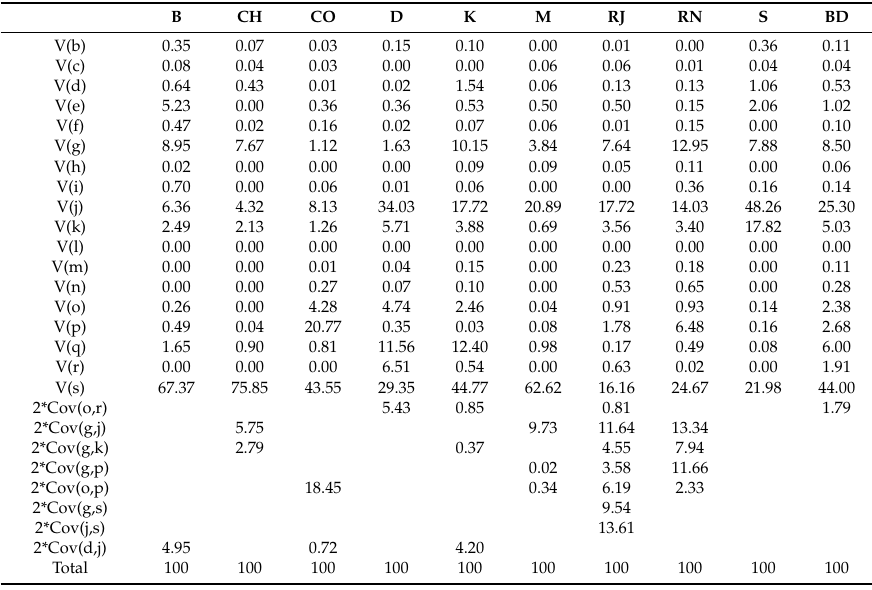
Table 7. Shares of crop income (%) in total agricultural income variation, by